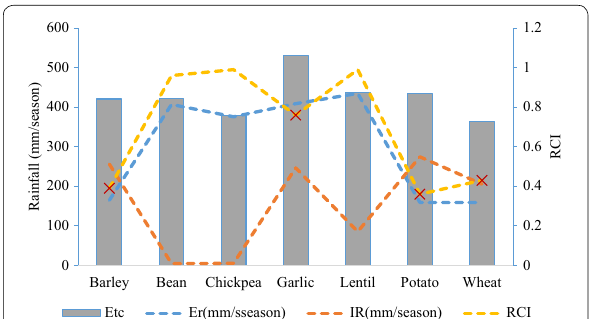
Fig. 5 Crop water and Irrigation Requirements. Etc is Crop evapotranspiration; Er is Effective rainfall; IR is Irrigation requirement; RCI is Rainfall Contribution Index. X Effective rainfall is insufficient in all growth stages (needs supplemental irrigation)